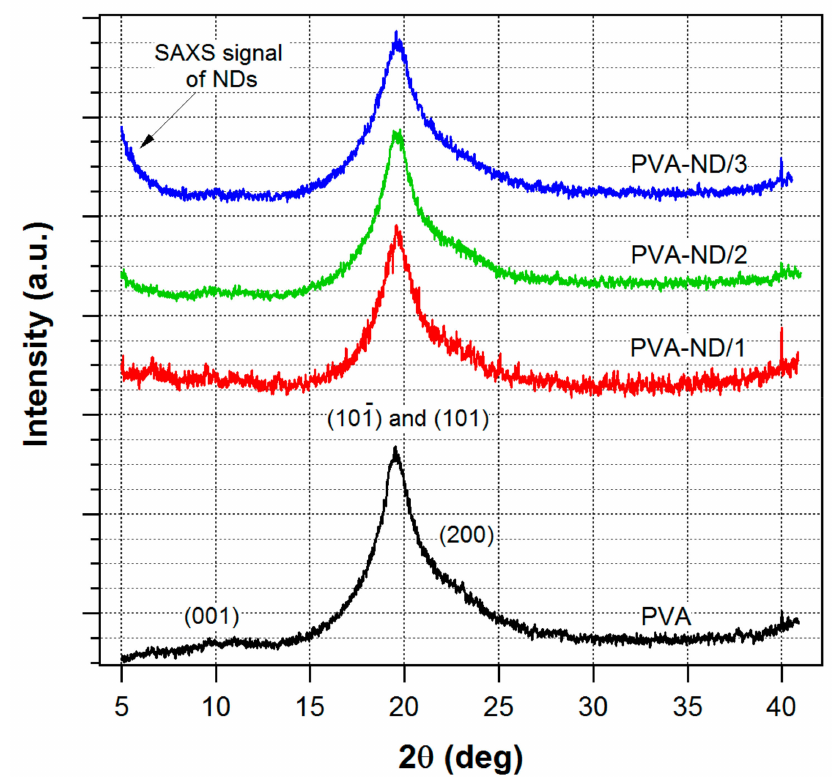
Figure 3. WAXS profiles of the pure PVA film and the nanocomposites.